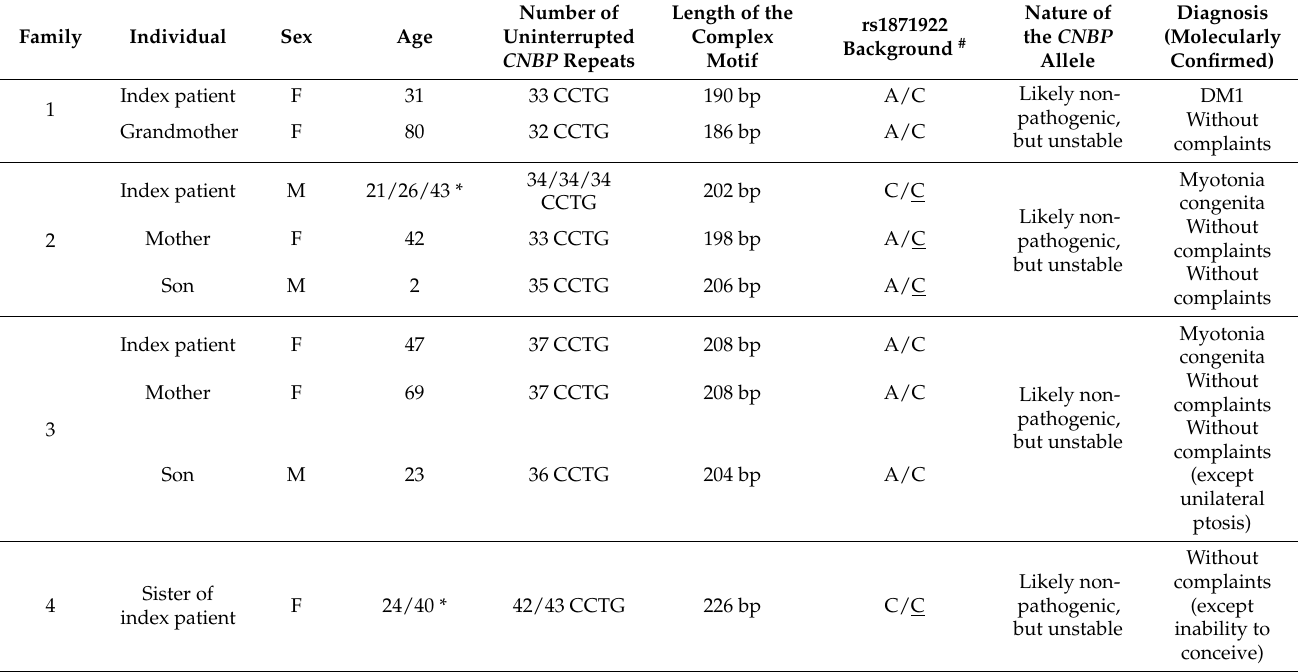
Table 1. Summary of findings in individuals carrying uninterrupted CCTG